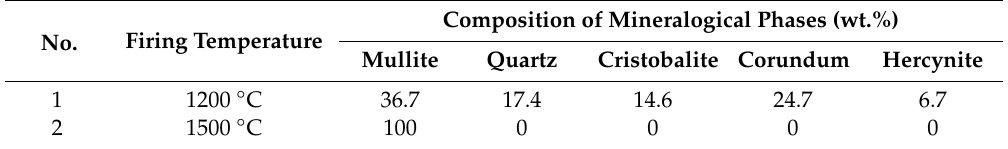
Table 2. Mineralogical compositions of the mullite precursor powder fired at 1200 ◦ C and 1500 ◦ C. Composition of Mineralogical Phases (wt.%) No. Firing Temperature Mullite Quartz Cristobalite Corundum Hercynite 1 1200 ◦ C 36.7 17.4 14.6 24.7 6.7 2 1500 ◦ C 100 0 0 0